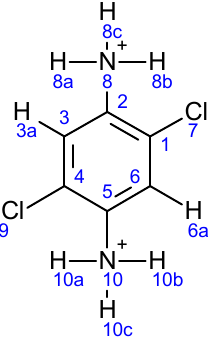
Figure 14. MEP surface of (C 6 H 8 Cl 2 N 2 ) 2 [Cd 3 Cl 10 ] · 6H 2 O.